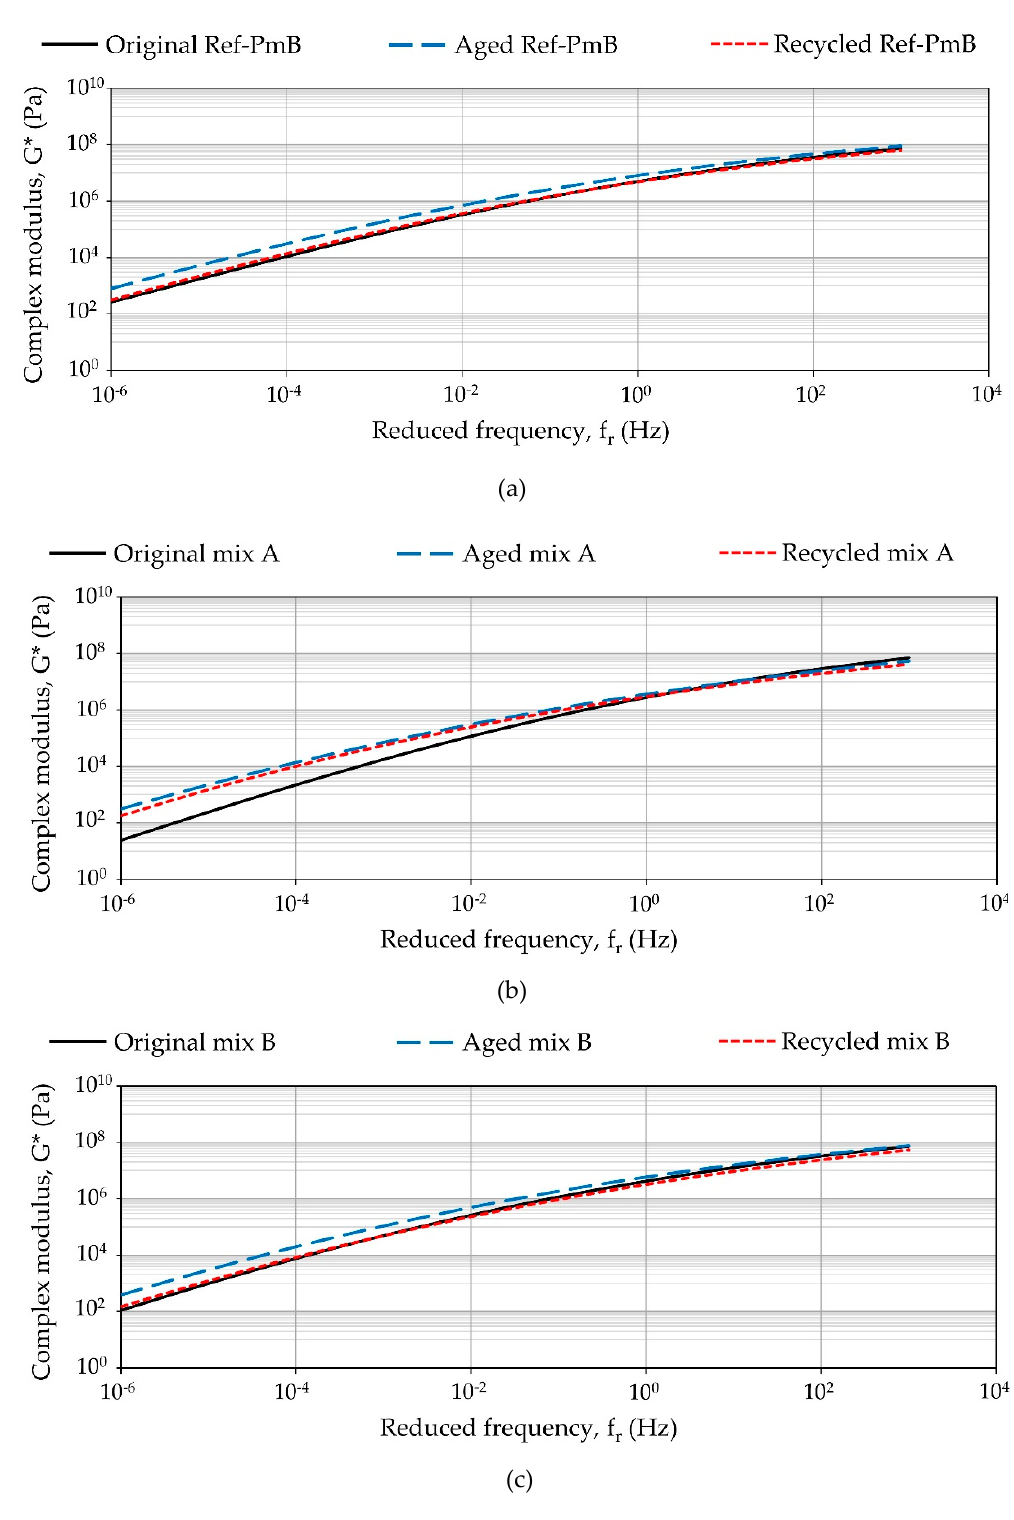
Figure 8. Complex shear modulus (G*) values of the recovered binder from ( a ) reference mixture, ( b ) Mix A, and ( c ) Mix B.